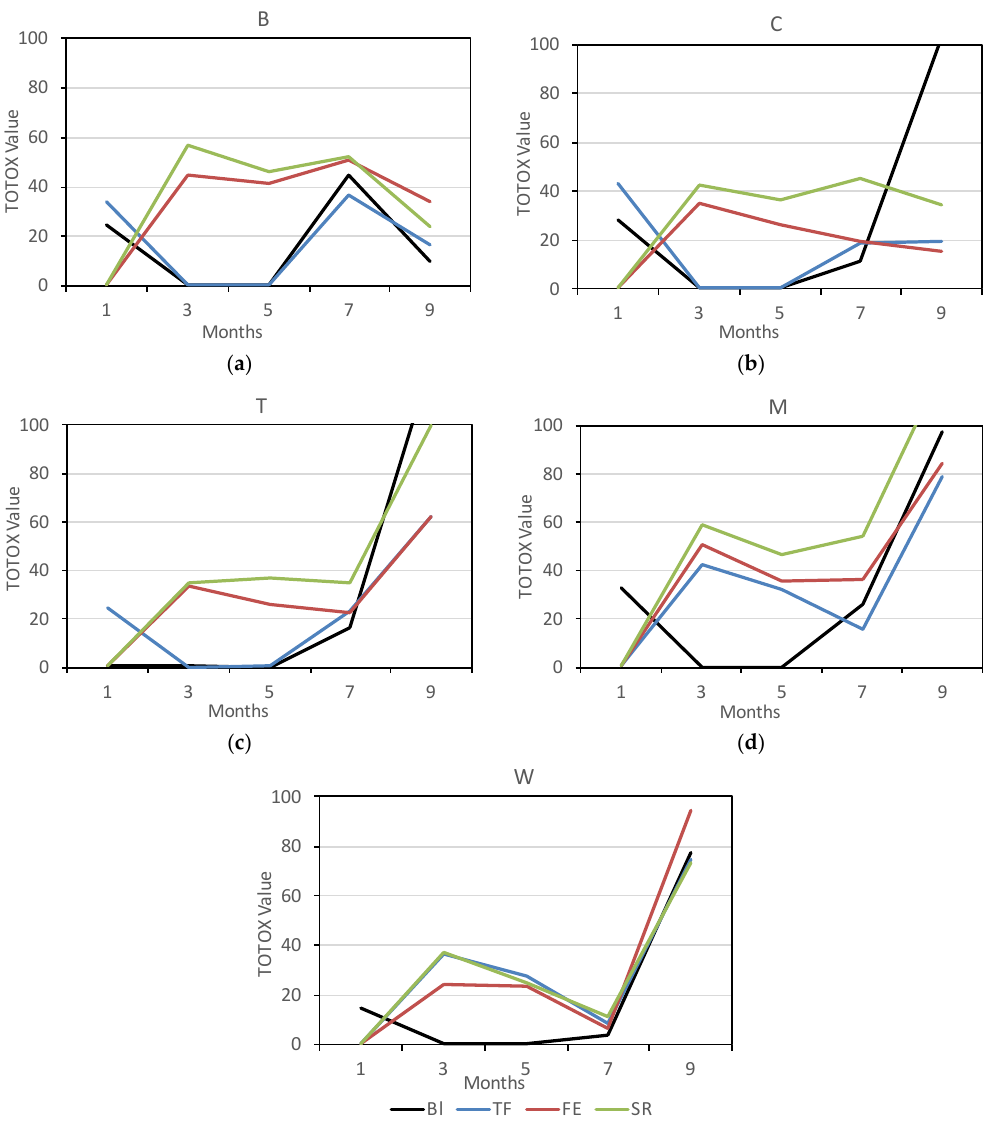
Figure 7. TOTOX value during simulated domestic consumption of suncream formulations prepared with thermal spring water from B ( a ), C ( b ), T ( c ), M ( d ), and W ( e ).